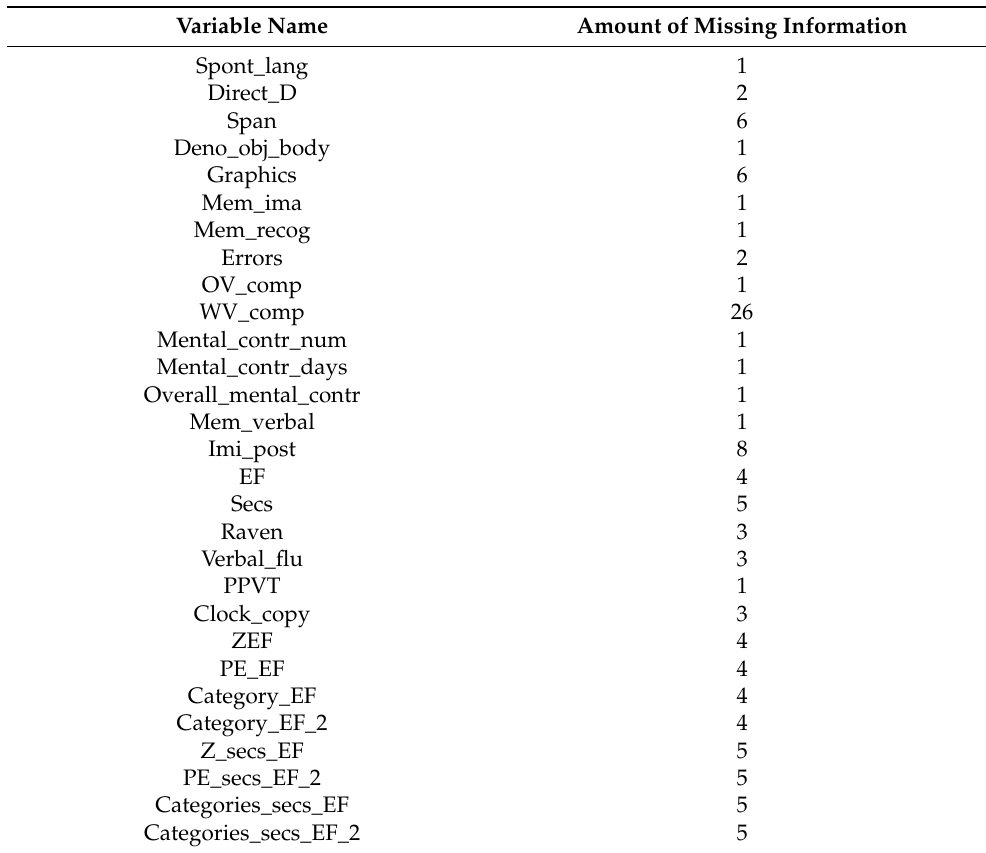
Table 2. Description of the fields with missing values.